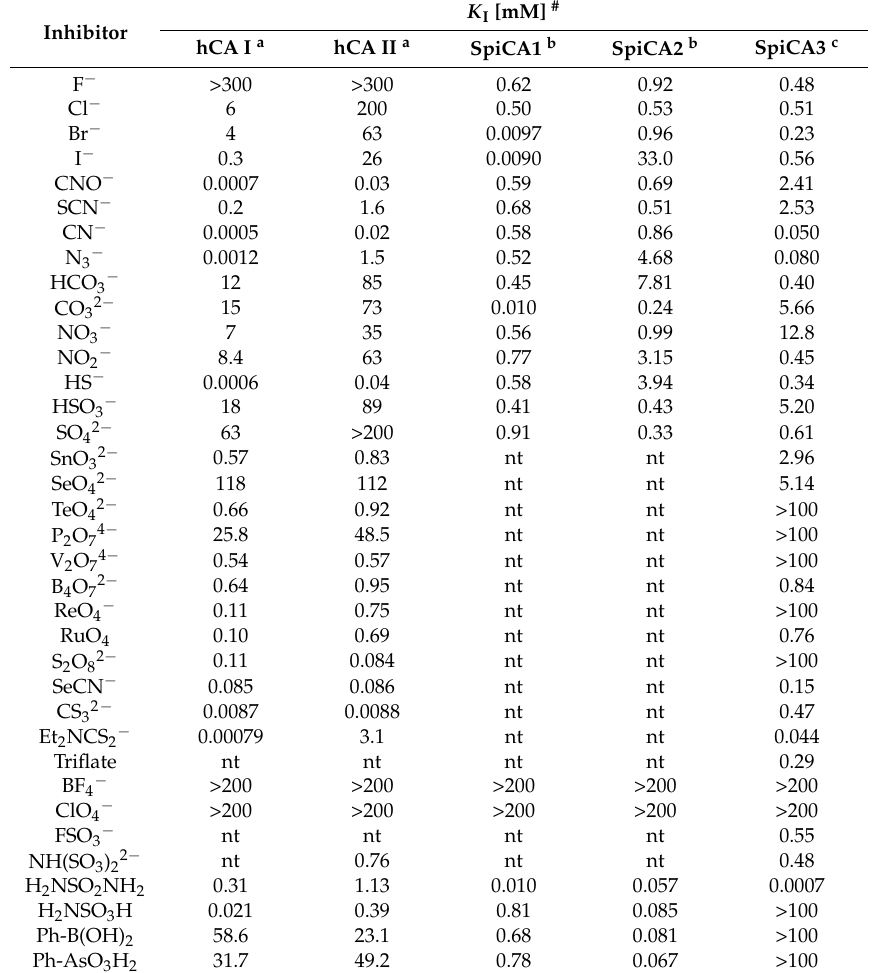
Table 2. Inhibition constants of anionic inhibitors against isozymes hCA I, II and VI (human, α -CA class enzymes), and the CA from the coral Stylophora pistillata , SpiCA1–STPCA3, for the CO 2 hydration reaction, at 20 ◦ C